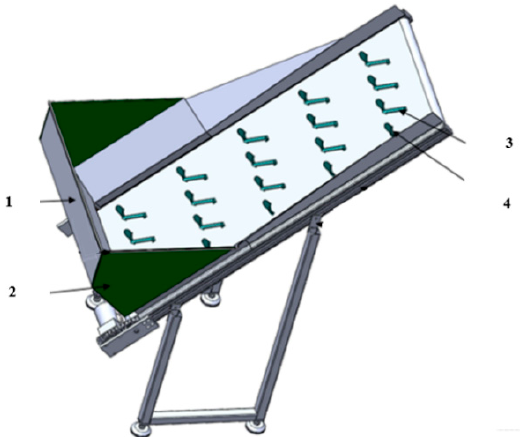
Figure 2. Scraper elevator. (1—hopper, 2—support plate, 3—guide plate, 4—curved scraper).